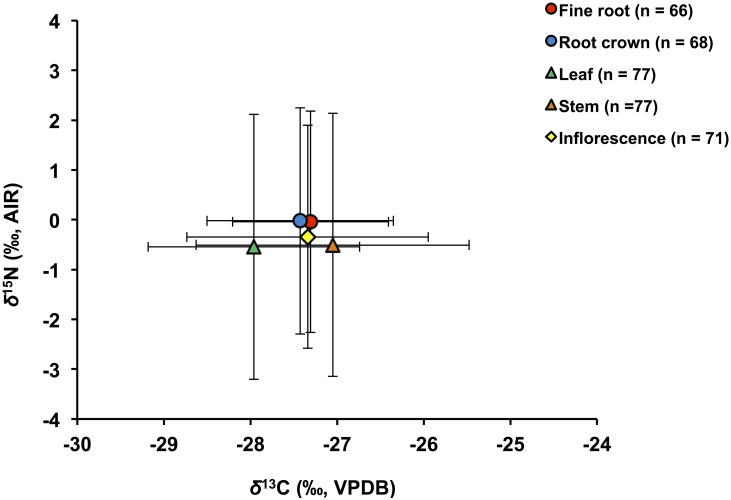
Mean (± SD) δ13C and δ15N of all plant parts analyzed, including fine root, root crown, leaf, stem and inflorescence.Below-ground plant parts have higher mean δ15N than above-ground parts, and foliar δ13C is lower than that of fine roots, stems and inflorescences, but only the latter is statistically significant (see text for details).